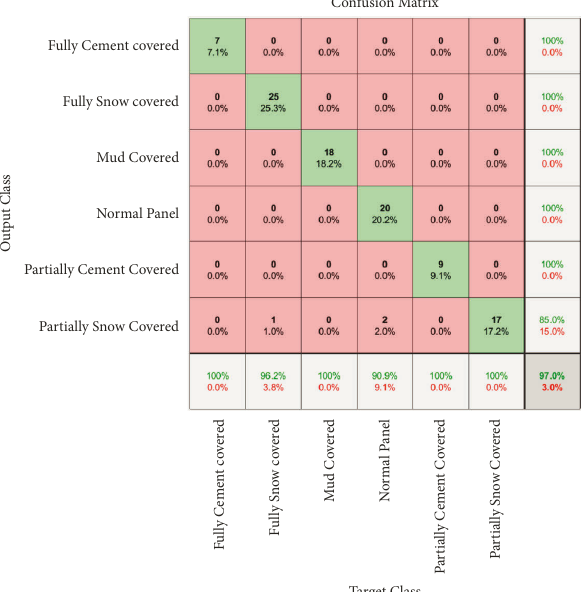
Figure 12: Confusion matrix for GoogleNet.